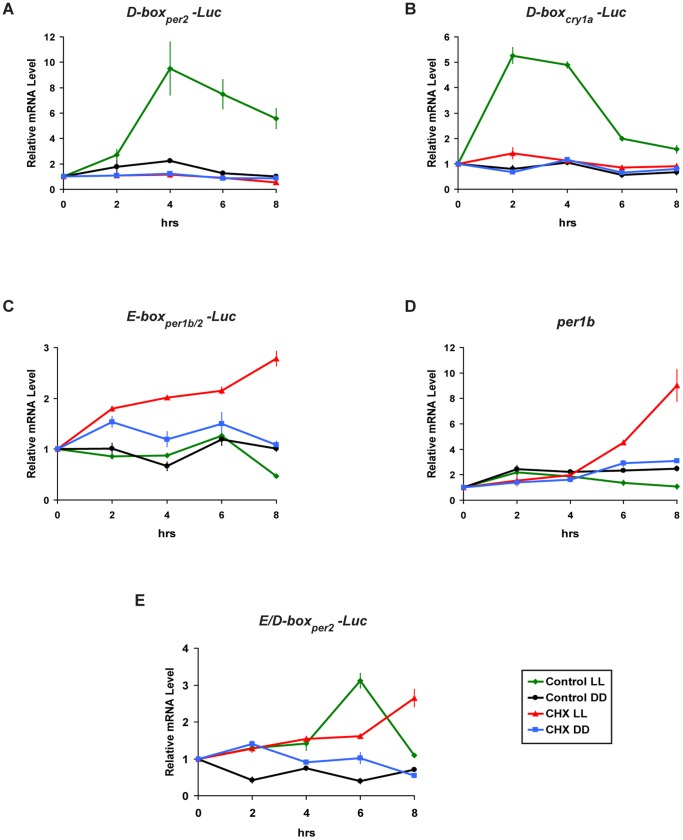
Light induced D-box enhancer activity requires de novo protein synthesis.(A–C and E) qRT-PCR analysis of luciferase mRNA expression in PAC-2 cells transfected with different heterologous luciferase reporter constructs, in the presence (red traces) or absence (green traces) of CHX during 8 hours of light exposure or DD conditions (+CHX, blue traces, −CHX, black traces). (D) qRT-PCR analysis of endogenous per1b expression in PAC-2 cells in the presence or absence of CHX during 8 hours of light exposure or DD conditions (colour coded the same as in panels A–C and E). Each construct is indicated above its respective panel. Relative mRNA levels are plotted on the y-axis and were set arbitrarily as 1 at time-point 0 hrs. Time (hrs) is plotted on the x-axis. In each panel, points are plotted as means of three independent experiments +/− SD. All statistical analyses (two-way ANOVA) are presented in Table S2 B or in the results section.